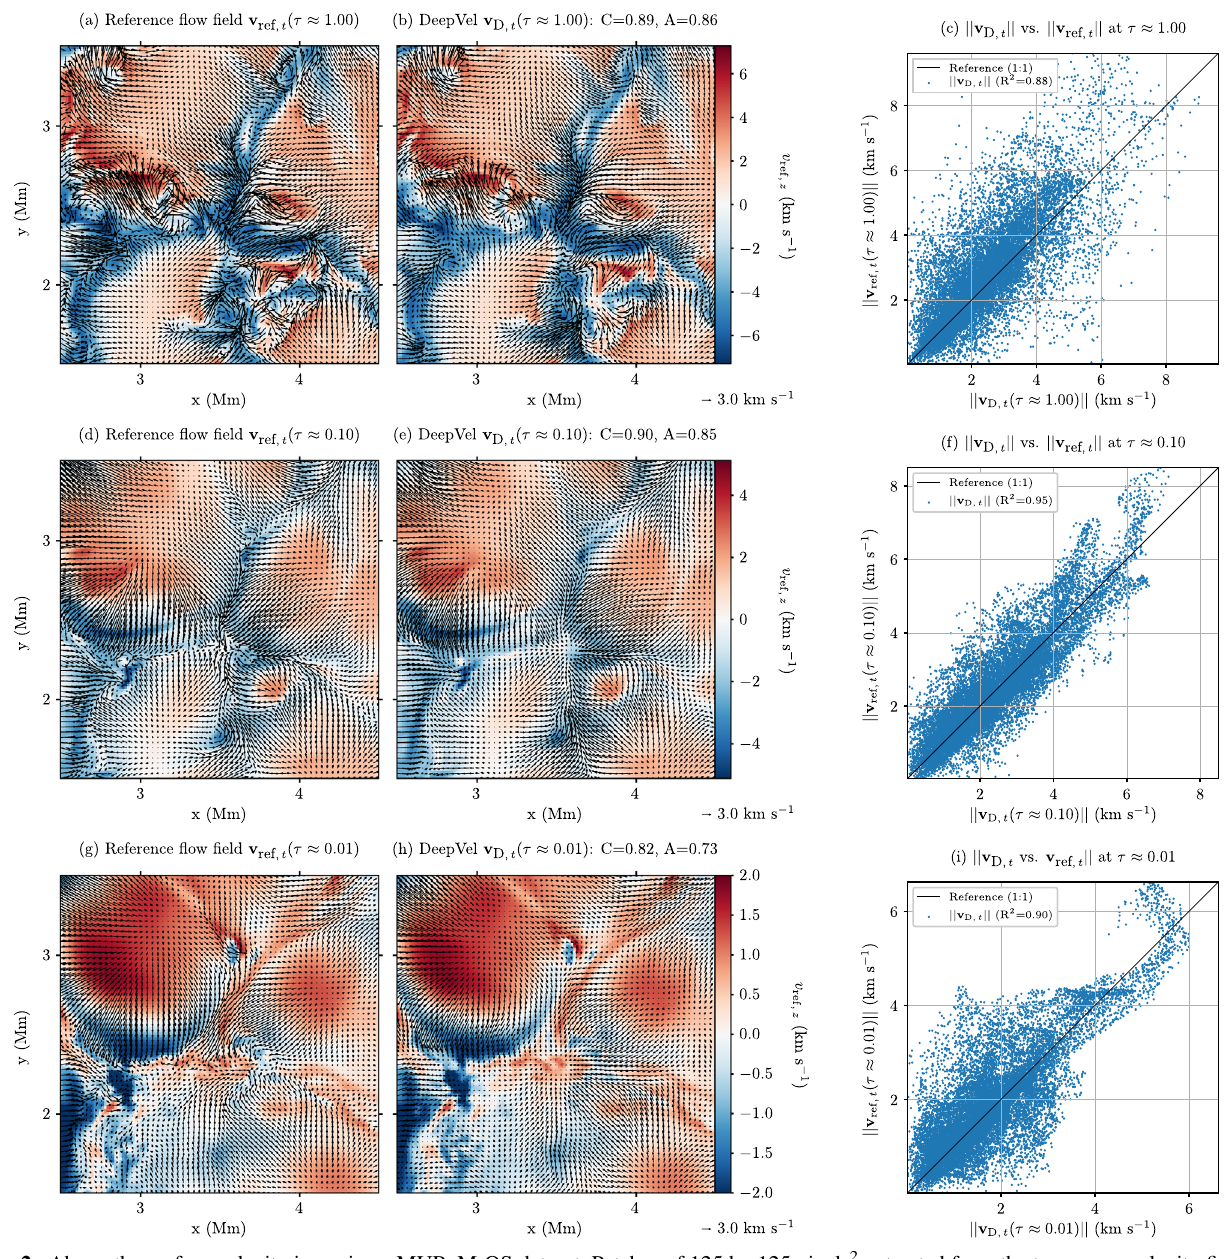
Fig. 2. Above the surface velocity inversions, MURaM-QS dataset. Patches of 125 by 125 pixels 2 extracted from the transverse velocity fi elds v s , t D , t ( i ) (left column) computed by the MURaM-QS simulation (Vögler et al., 2005) and (middle column) inferred by DeepVel at optical depths (top) s (cid:2) 1, (middle) s (cid:2) 0.1 and (bottom) s (cid:2) 0.01. The vertical velocity v ref, z ( s (cid:2) {1, 0.1, 0.01}, t i ) computed by the MURaM-QS simulation is displayed as colored background with a symmetrical threshold. (Right column) Scatterplots comparing amplitudes || v D , t || to || v ref, t ||. The black line represents the expected solution (i.e., a coef fi cient of determination R 2 =